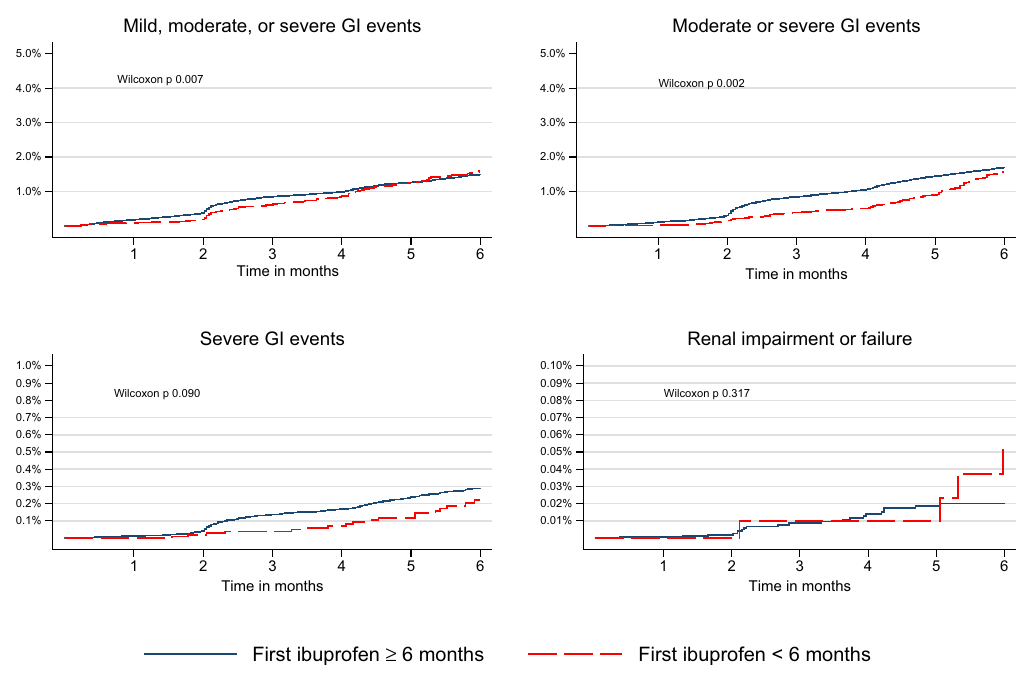
Fig 2. Kaplan-Meier failure curves for adverse events during six-month follow-up after the first prescription of ibuprofen. GI; Gastrointestinal. https://doi.org/10.1371/journal.pone.0199493.g002 570 were severe. There was little difference in most outcomes at 14-day follow up (Table 6). At six-month follow up there were higher rates of the combined endpoints of any (aRR 1.48, 95%